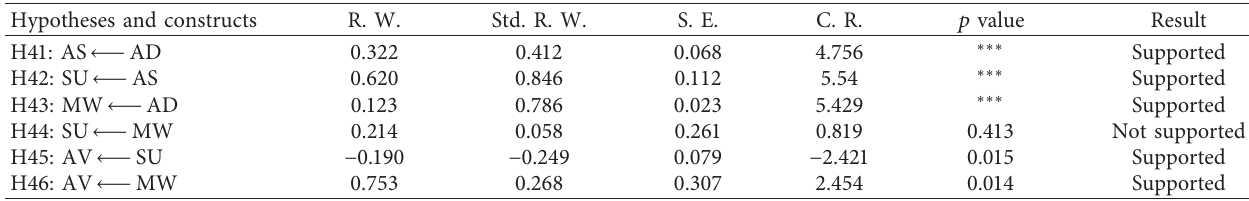
Table 5: Result of the path